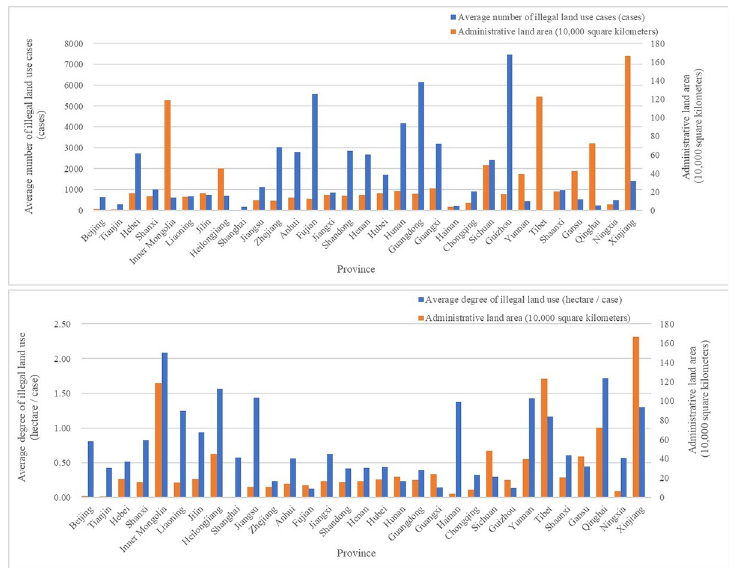
Fig 3. Land law enforcement difficulty and illegal land